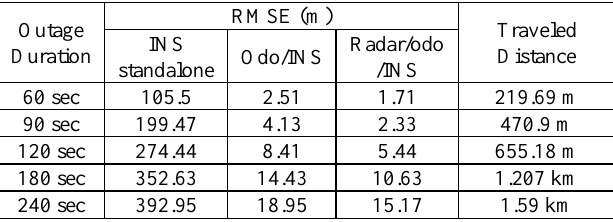
Table 1. Horizontal position RMSE for different GNSS signal outage durations for INS standalone, odometer/INS integration, and Radar/odometer/INS integration Figure 5. The setup of Radar units and Pixhawk 4 Board on Testing Vehicle Roof.